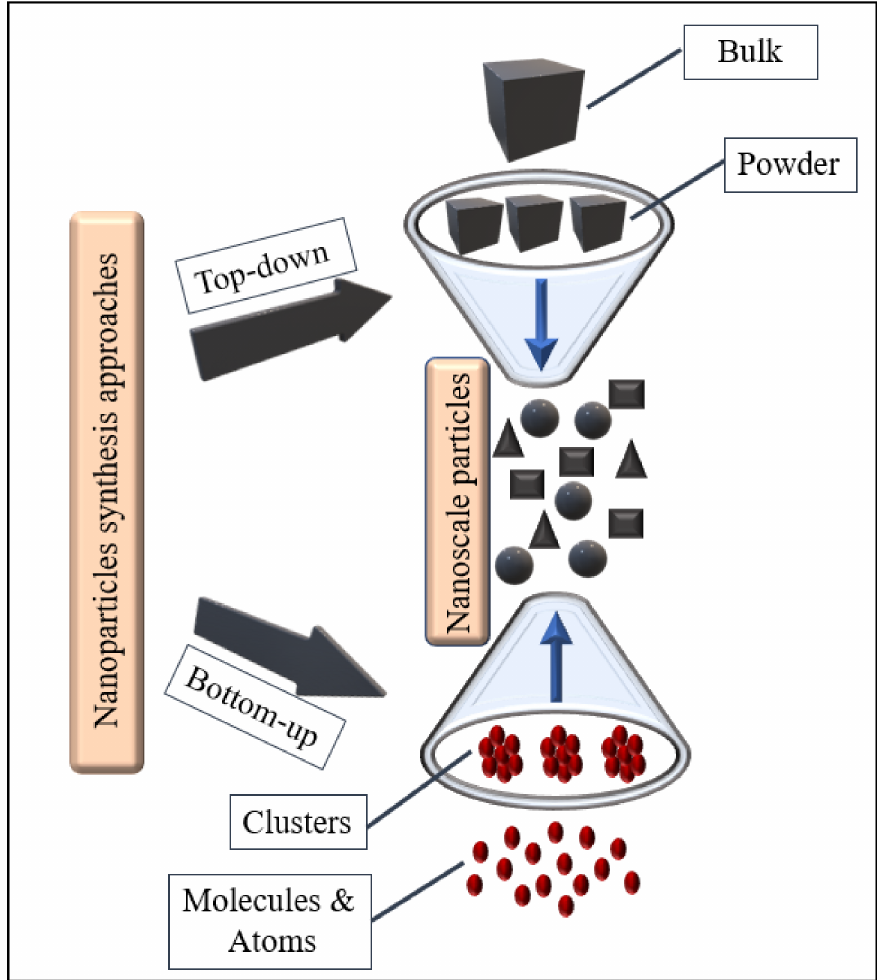
Figure 1. A simplified interpretation of the bottom-up and top-down ways. For the biosynthesis of metal nanoparticles (MNPs), the bottom-up method is used where small atoms and molecules are combined into clusters and then to nanoscale particles. Contrariwise, in the top-down method, the nanoparticles (NPs) are created from the bulk